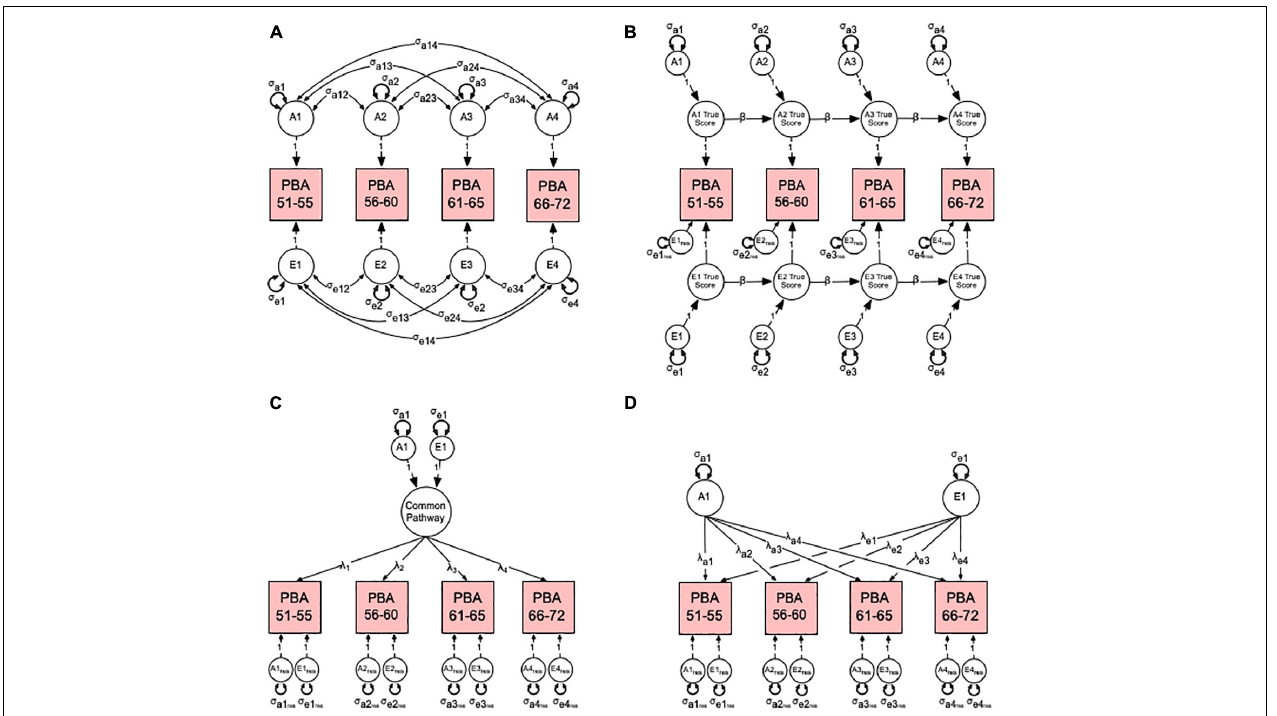
FIGURE 2 | Multivariate correlated factors (A) and competing hypothetical models to explain the sources of variance-covariance between the predicted brain age (PBA) scores. Competing models include (B) the auto-regression, (C) common pathway, and (D) independent pathway models. For brevity, only latent additive genetic (A1–4) and non-shared environmental (E1–4) factors are shown. (A) The multivariate correlated factor model estimates the size of the latent genetic and environmental variances and covariances (double-headed arrows). It is atheoretical and makes no prediction about the nature of change in PBA over time. (B) In the autoregression model, the time-specific genetic ( σ a1 − 4 ) and environmental ( σ e1 − 4 ) variance components or “innovations” for each genetic (A1–4) and environmental (E1–4) latent factor true score are estimated along with each variable’s residual or error variance ( σ e 1res − e4res ). Also estimated are the autoregression or causal coefficients ( β ) from one latent true score to the next. (C) In the common pathway model, the genetic ( σ a1 ) and environmental ( σ e1 ) variance components for the common pathway, the factor loadings ( λ 1 − 4 ), and latent genetic and environmental residuals ( σ a1res − a4res , σ e1res − e4res ) are estimated. (D) Finally, in the independent pathway model, genetic ( σ a1 ) and environmental ( σ e1 ) variance components are estimated independently with their factor loadings ( λ a1 − 4 , λ e1 − 4 ), and latent genetic and environmental residuals ( σ a 1res − a4res , σ e1res − e4res ). See Supplement for more detailed modeling